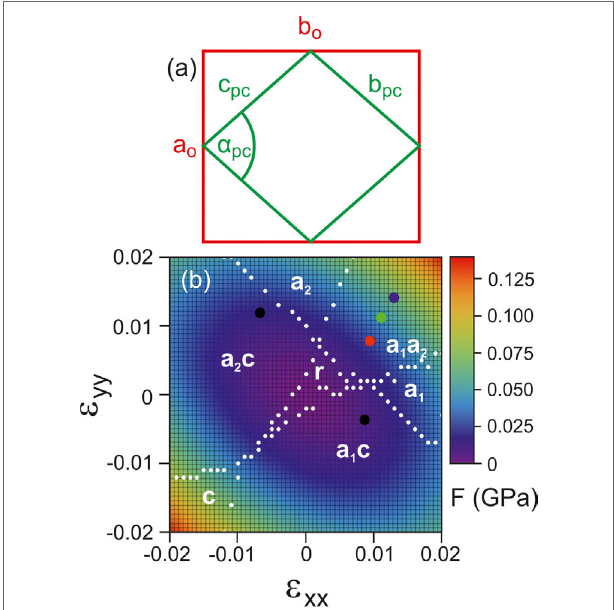
FigUre 2 | (a) Schematic presentation of the orthorhombic (red) and pseudocubic (green) unit cells of K x Na 1 − x NbO 3 . The angle α pc is connected to the monoclinic distortion angle β by α pc = 90° −β . (b) Calculated strain-phase diagram for KNbO 3 using Landau–Ginzburg–Devonshire theory. The black circles indicate the strain conditions for (001) pc and (100) pc oriented K 0.9 Na 0.1 NbO 3 on (110) NdScO 3 , while the red, green, and blue circles illustrate the situation for (100) pc oriented NaNbO 3 on (110) DyScO 3 , TbScO 3 , and GdScO 3 , respectively. The white circles mark the stability transition